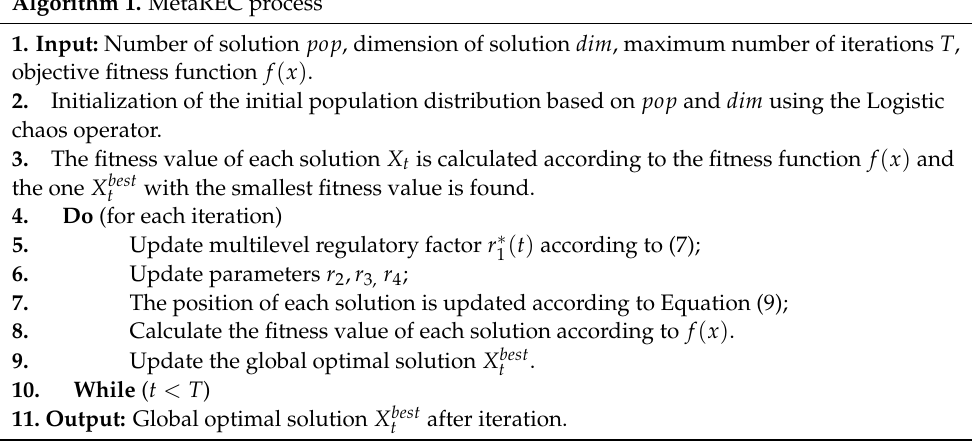
Algorithm 1. MetaREC